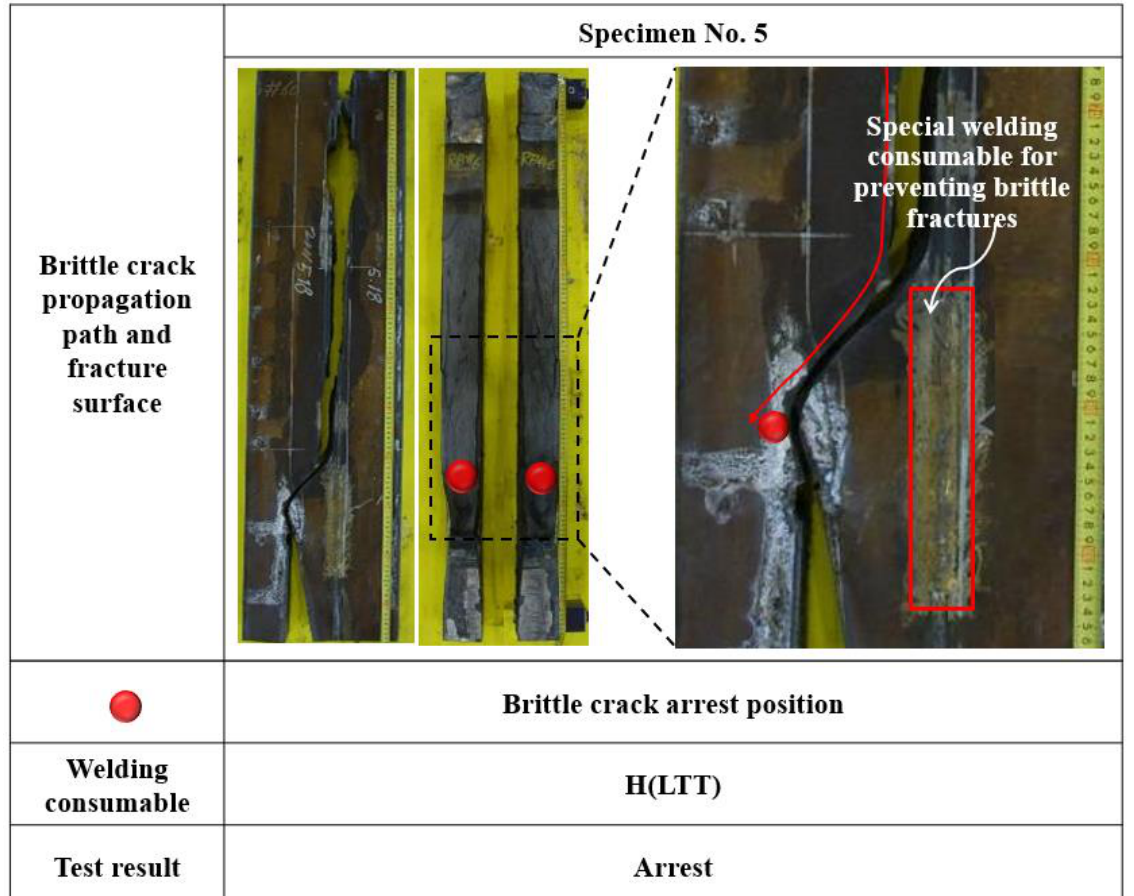
Figure 9. Brittle crack arrest position of